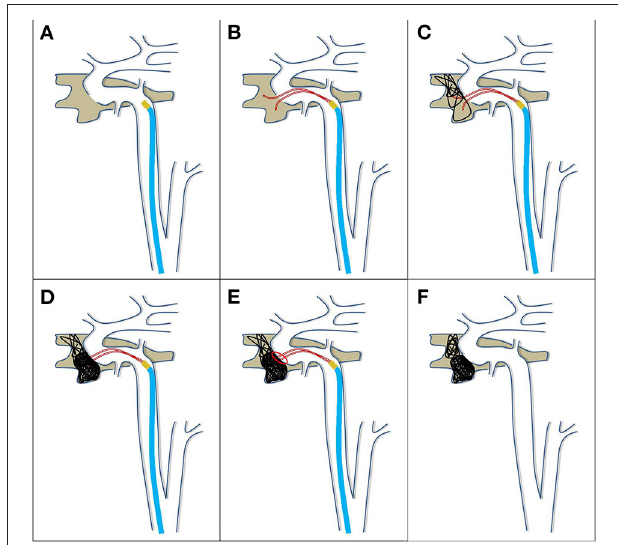
FIGURE 2 | Schematic diagram of the treatment for direct CCF by point-to-point coil embolization of the fistula. Procedure: first, the location of the fistula was accurately determined (A) ; second, the double microcatheters were preset, one shallow and one deep (B) ; third, a basket with a large coil was formed by the deep microcatheter (C) ; fourth, the coils were filled into only the part close to the fistula, until tight filling by the shallow microcatheter (D) ; fifth, the microcatheters were withdrawn, and the closure of the fistula was confirmed (E,F)